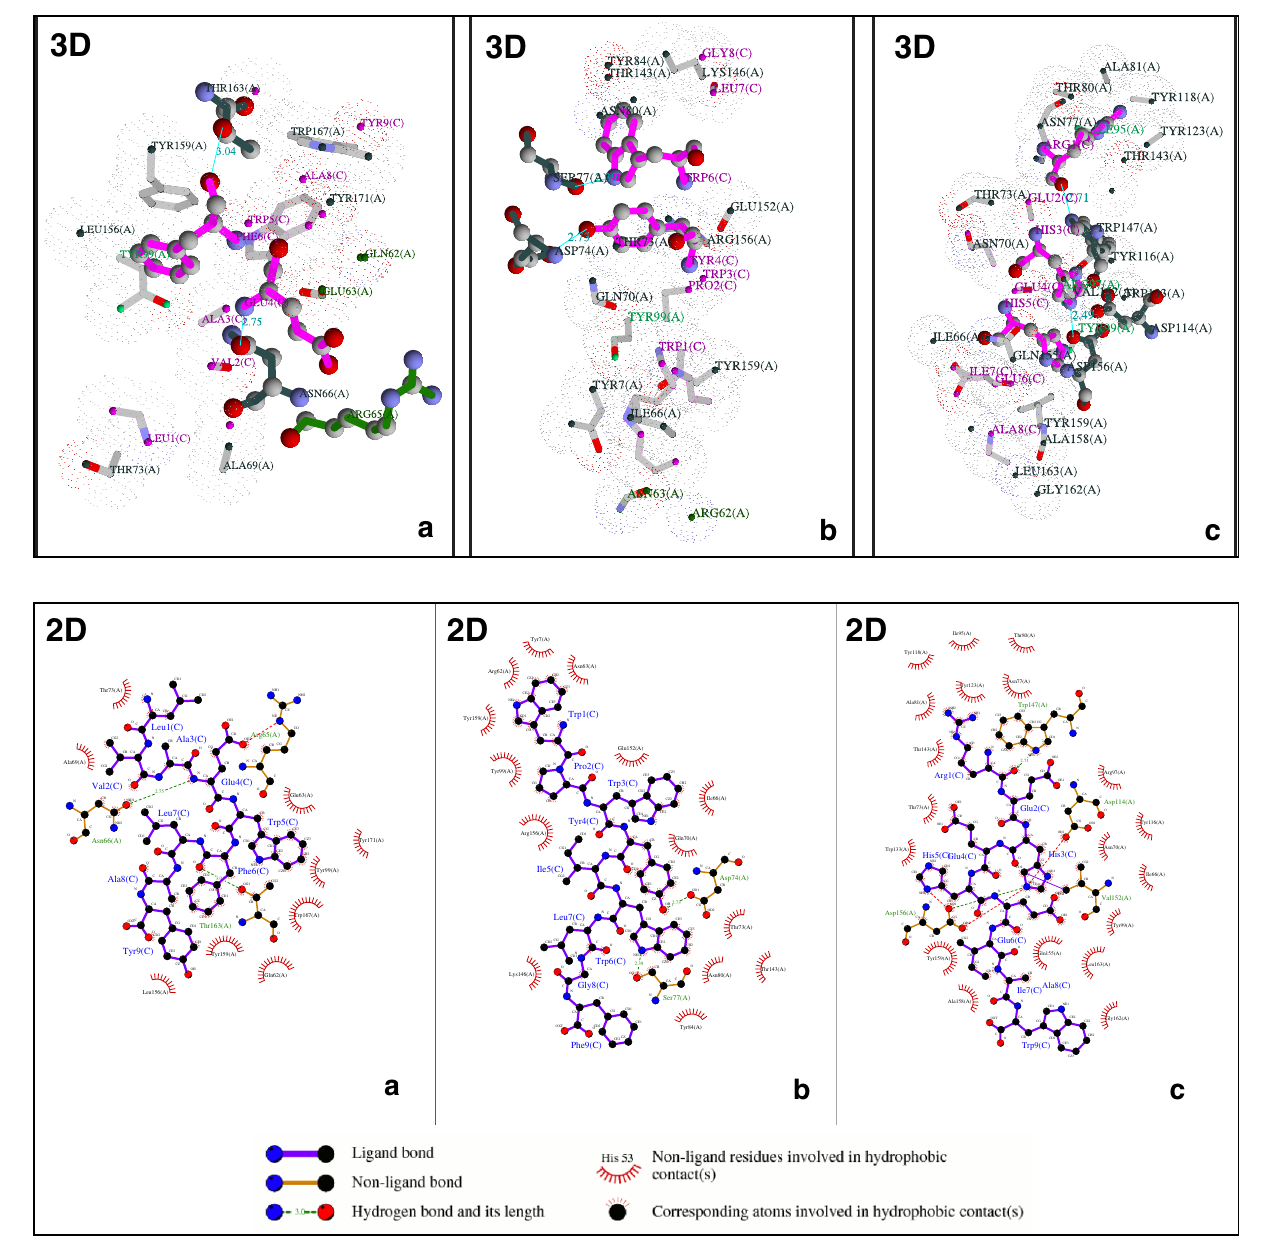
Figure 4. The two-dimensional and three-dimensional representation of the interactions between the identified epitope and the corresponding HLA. ( a ) HLA-A3—LVAEWFLAY. ( b ) HLA-B7—WPWYIWLGF. ( c ) HLA-